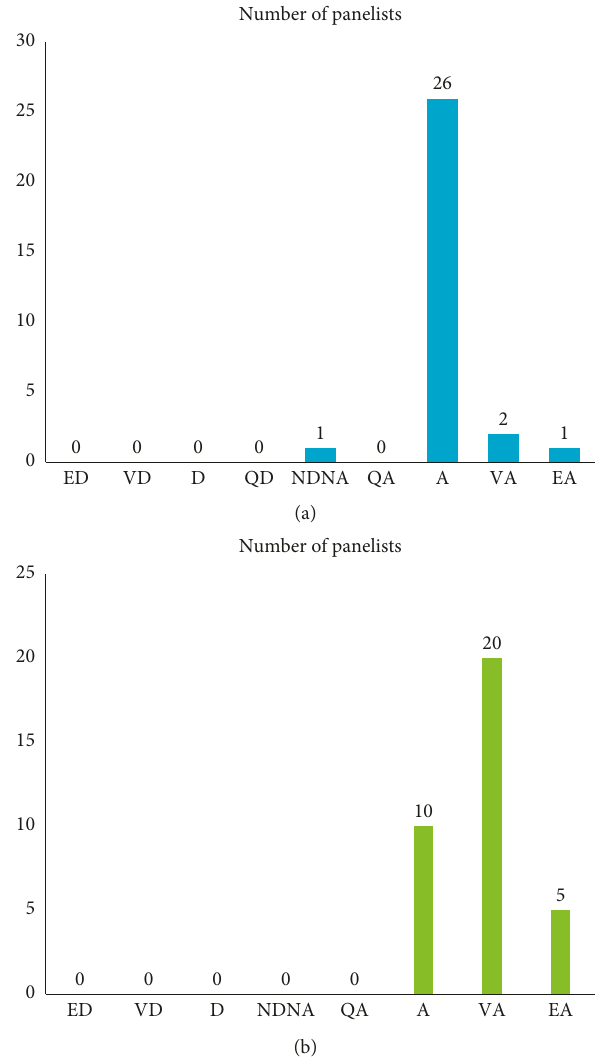
Figure 7: General acceptability concerning F (a) and G (b) formulations. ED: extremely disagreeable; VD: very